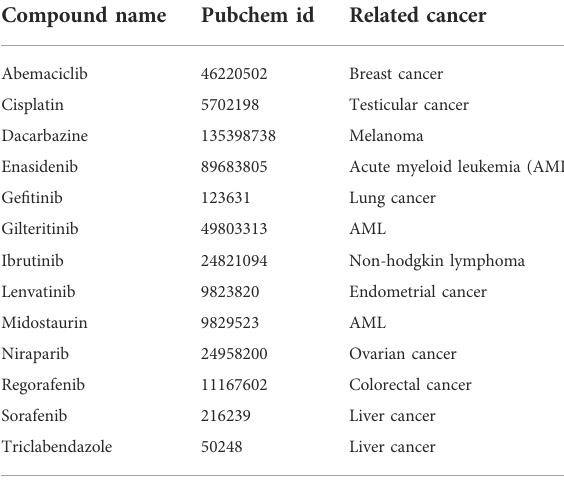
TABLE 1 Cancer-associated drug compounds used for docking to